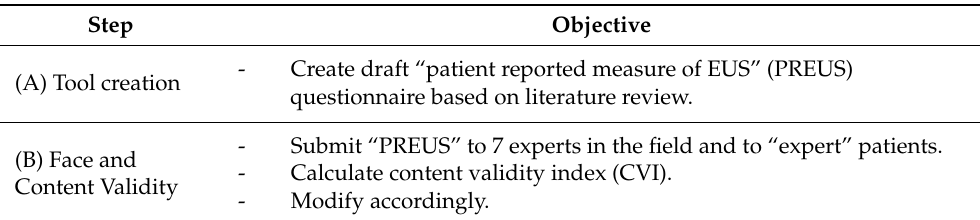
Table 1. Schematic representation of the study steps toward the creation of a dedicated tool to measure patients’ reported experience during endoscopic ultrasound